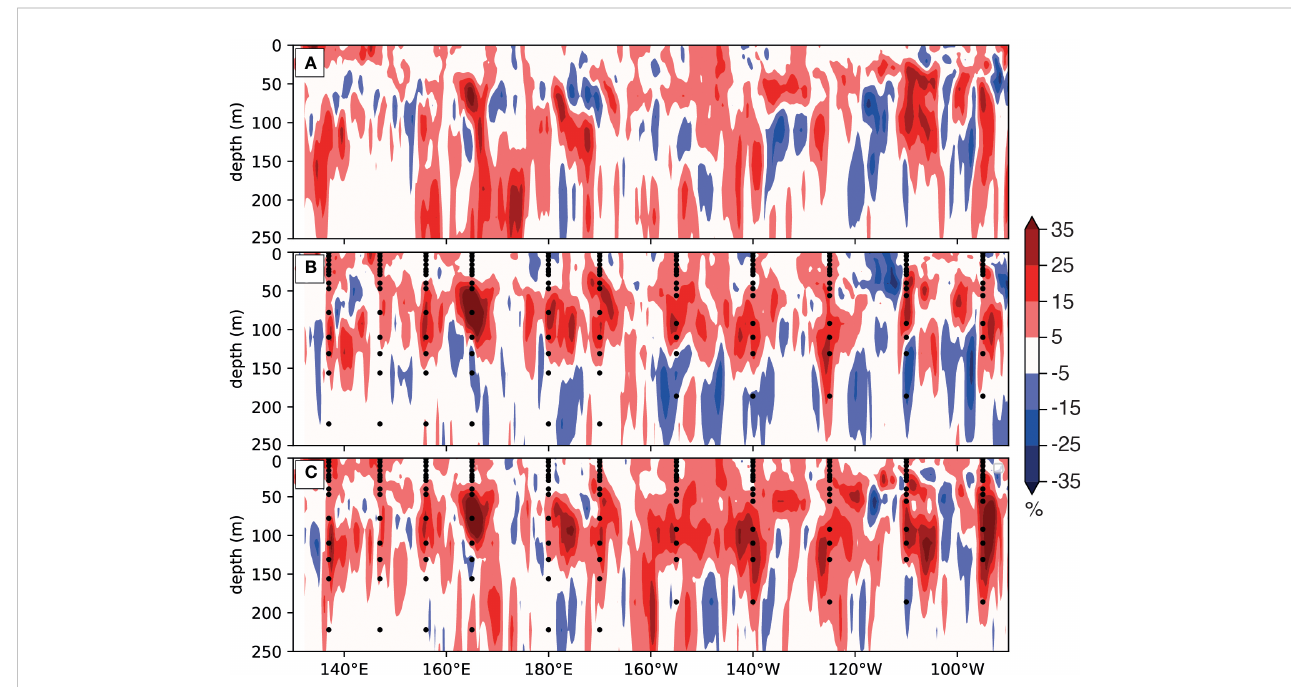
FIGURE 11 Difference of percentage of Nature Run (NR) salinity represented variance at intermediate scales from the NOMINAL experiment for (A) ENHANCED_AR, (B) ENHANCED_MO and (C) ENHANCED_AR_MO experiments along the equatorial Paci fi c. Red colors represent improvement of enhanced experiments compared to